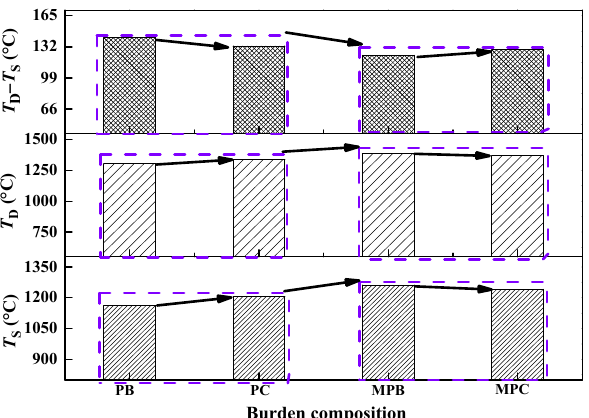
ff ect of burden compositions of pellets on the melting behavior. Metals 2019 , 9 , x FOR PEER REVIEW Figure 10. Effect of burden compositions of pellets on the melting behavior. Figure 10. E